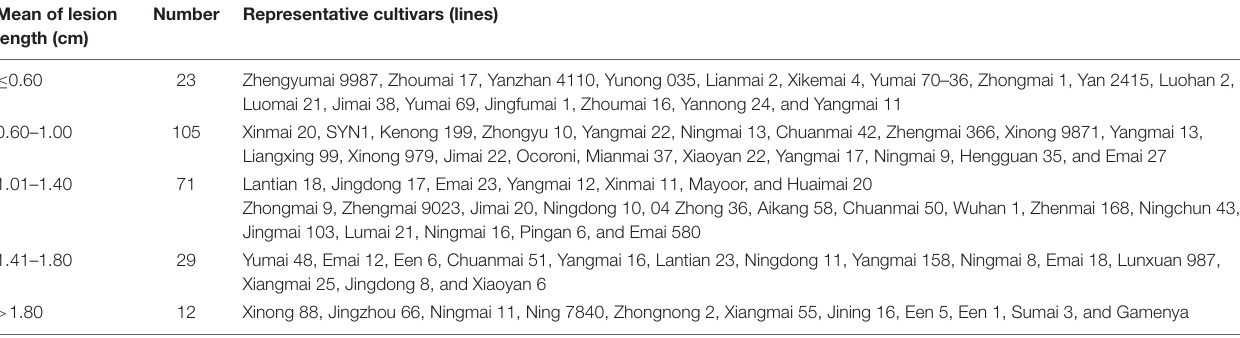
TABLE 2 | Materials with different resistance levels to Fusarium seedling blight (FSB) (only representative materials are shown). Mean of lesion Number Representative cultivars (lines) length (cm) ≤ 0.60